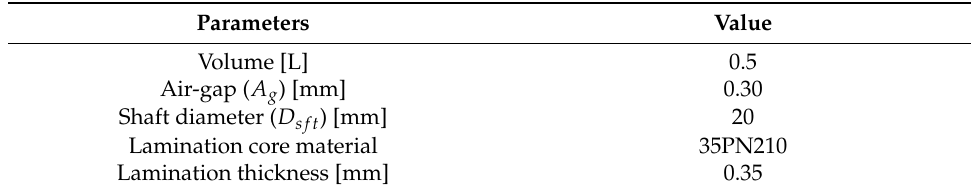
Table 2. Fixed parameters.